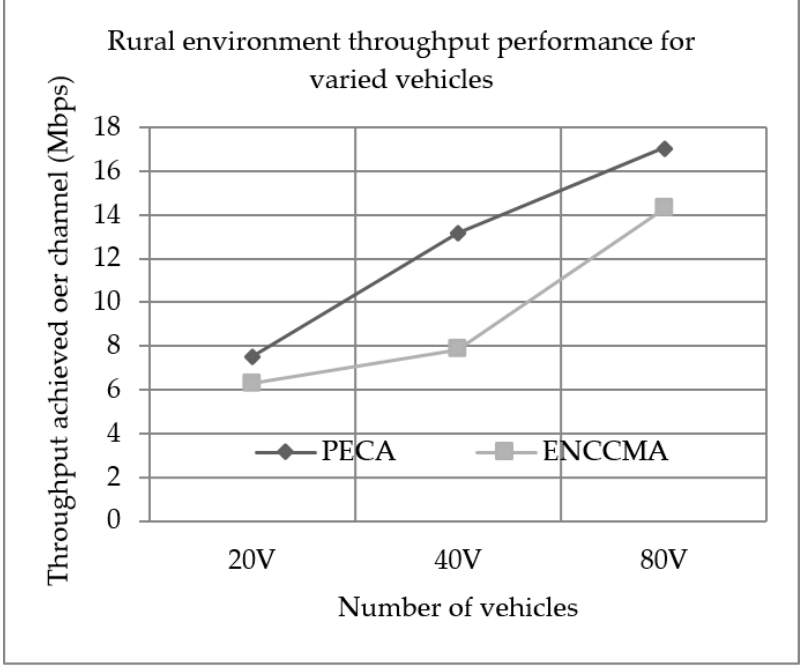
Figure 3. Rural environment throughput performance for varied vehicles.